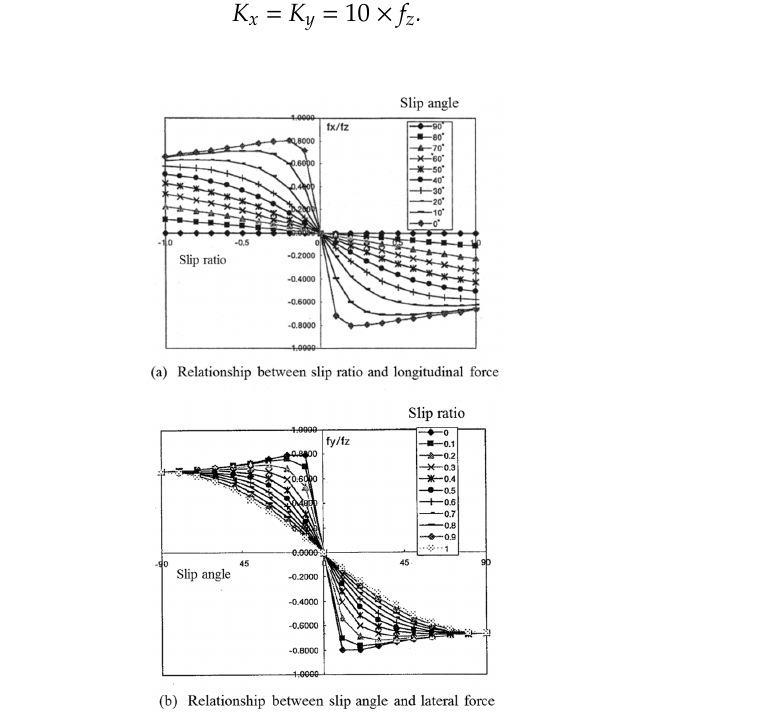
Figure 3. Slip characteristics of tire. ( a ) Relationship between slip ratio and longitudinal force where slip angle is changed from 0 degree to 90 degrees. ( b ) Relationship between slip ratio and lateral force where slip ratio is changed from 0 to 1.